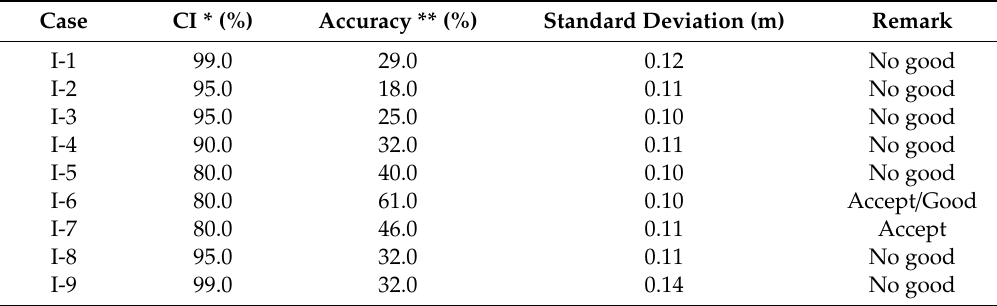
Figure 6. Results of the flood forecasting model according to Scenario II (( A ) = 1 h leading time; ( B ) = 3 h leading time; ( C ) = 6 h leading time; ( D ) = 9 h leading time; ( E ) = 12 h leading time; ( F ) = 15 h leading time; ( G ) = 18 h leading time; ( H ) = 21 h leading time; ( I ) = 24 h leading time). Table 8. Summary of confidence intervals for various weights in Scenario Table 10. Summary of the accuracy for various leading times in Scenario Ⅱ (Period: 5–7 July 2016